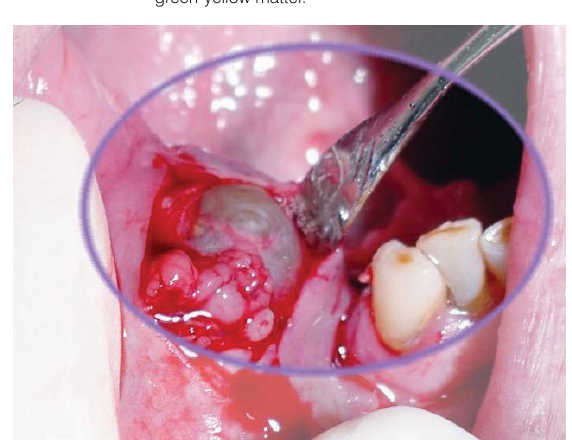
Figure 3. Bluish-colored tumor of elastic consistency, clearly outlined against the surroundings, filled with liquid green-yellow